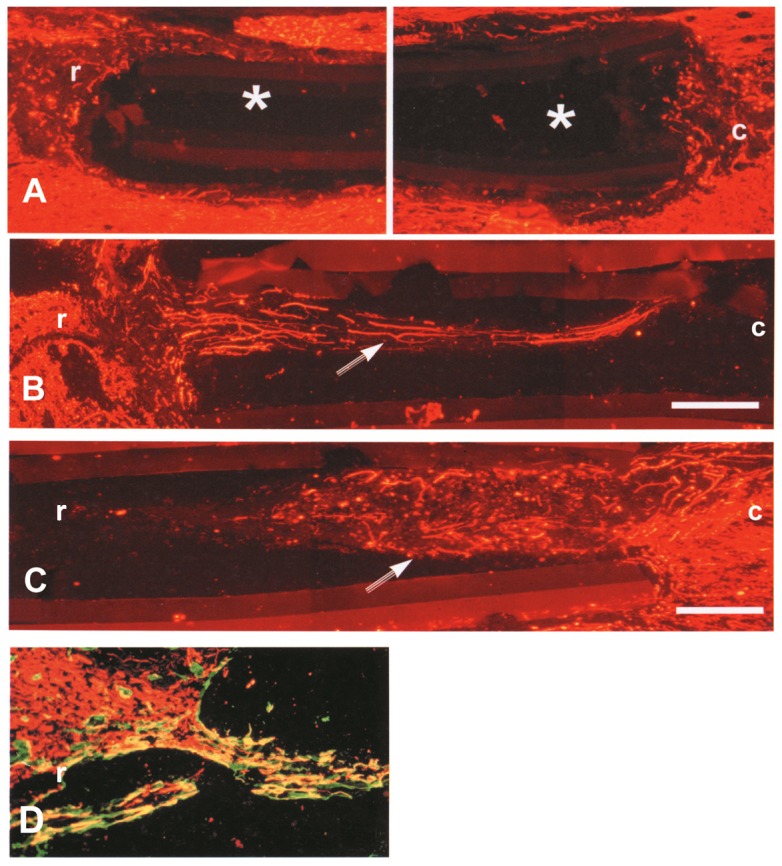

In vivo effects of NX210 on neuritic regrowth in a rat model of SCI.The injury was performed by aspirating the dorsal funiculi and the dorsal horns of the spinal gray matter. A collagen tube filled with the vehicle (A) or NX210 (B and C) was placed into the site of injury. Neuritic regrowth was detected using neurofilament immunostaining. (A) In the vehicle group (n = 5), the collagen tube remains empty without neuritic regrowth (*). (B and C): in the NX210 group (n = 5), neuritic regrowth (arrow) is clearly observed inside the collagen tube, mostly from the caudal end of the lesion. Neofibers display a longitudinal arrangement. (D): At the surface of the growing processes, NF was co-localized with laminin, a marker of the basal lamina. r: rostral; c: caudal; Scale bar: 250 μm.